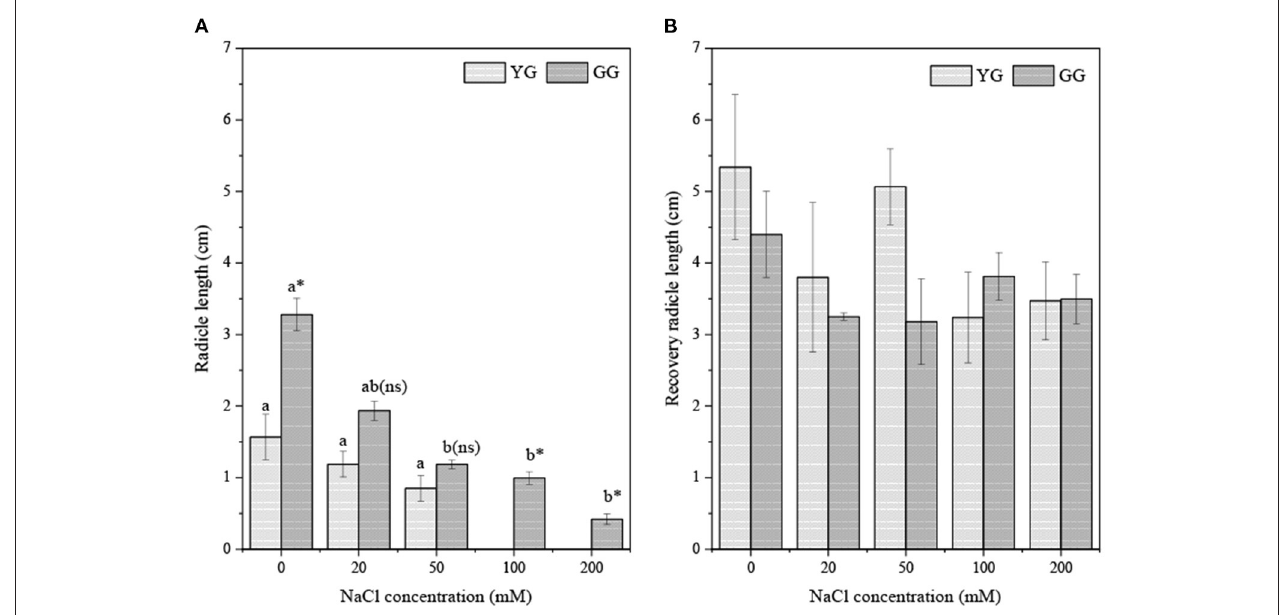
FIGURE 5 | Effects of salt stress on radicle length of seedlings grown from different L. chinensis ecotypes (A) the initially germination (B) the recovery germination; There were twenty replicates for each treatment. Values are presented as means ± standard error (SE); Different lowercase letters indicate significant differences between the different NaCl concentrations under the same ecotype. * , ** , *** Indicate significant differences between the different ecotypes under the same NaCl concentration at 0.05, 0.01, and 0.001 level respectively, and “ns” indicates no significant